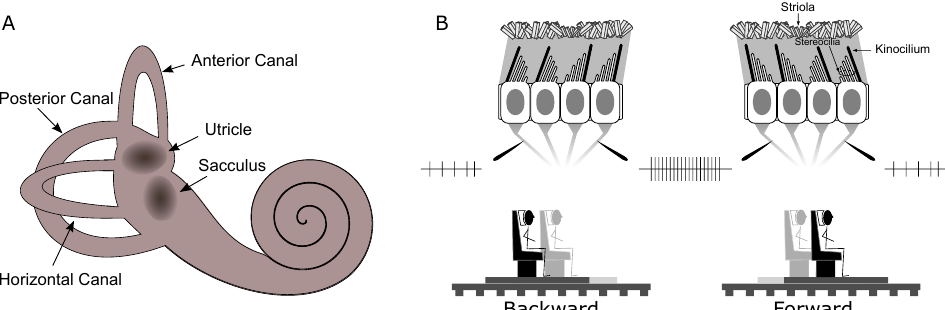
Figure 2. ( A ) The peripheral vestibular system. Pictorial representation of the semicircular canals and the otolith organs (utricle and sacculus). ( B ) Activation of the neural afferents in response to a backward (left column) and forward (right column) movement. In the top row, the physiological response is represented: the afferents increase their firing rate only when the stereocilia bend toward the Kinocilium. Oppositely tuned cells are separated by a section of the macula with smaller otoconia called the striola. In the bottom row, movements are represented as they can be elicited in the laboratory with a motion platform as in